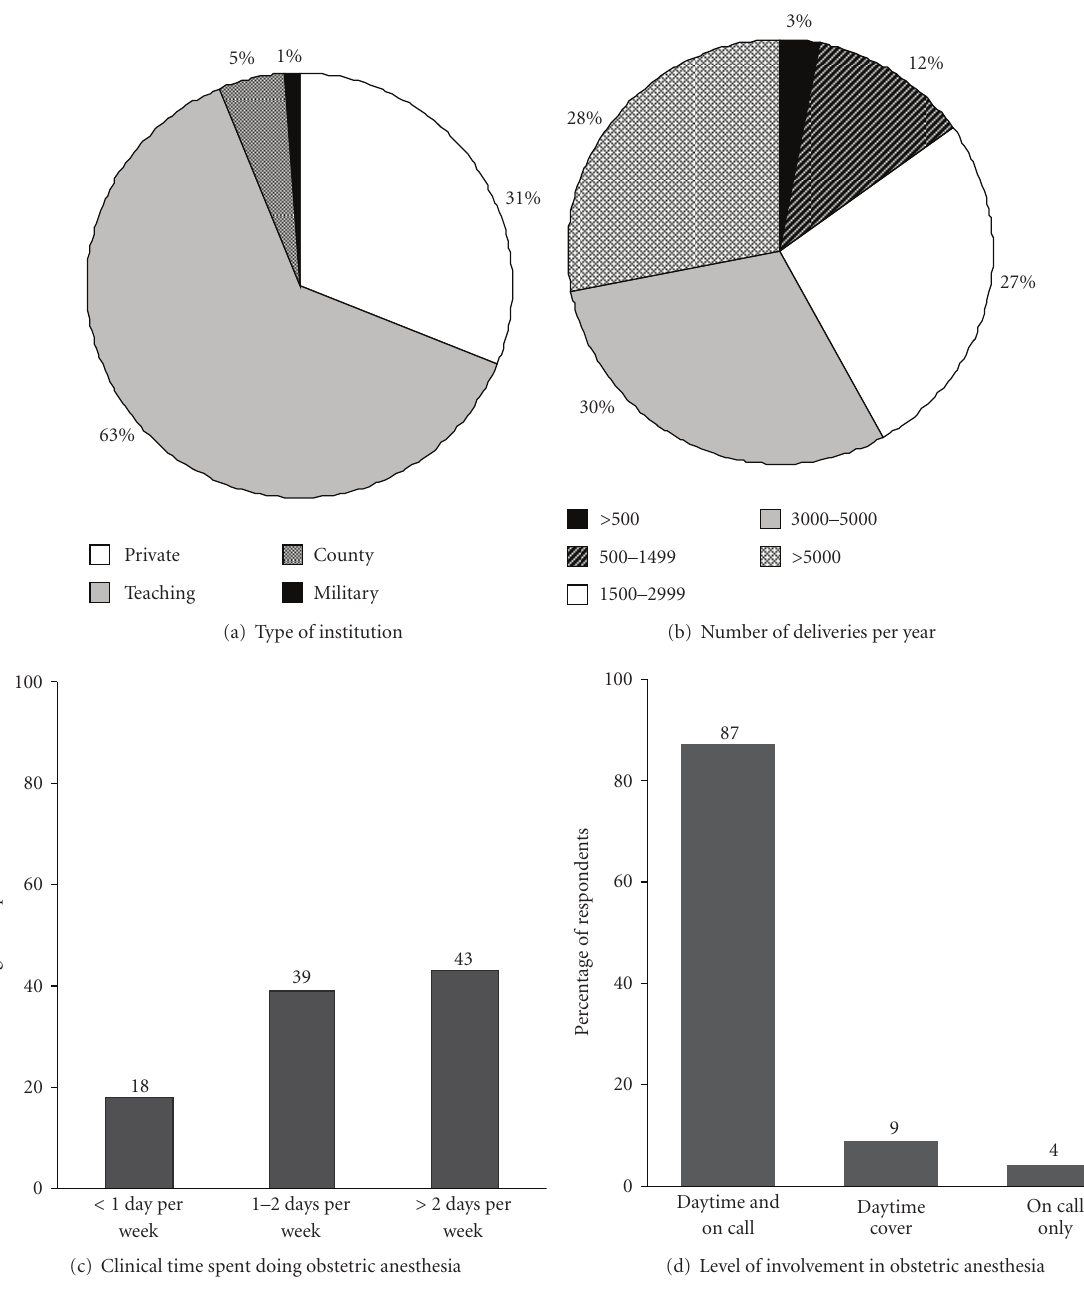
Figure 1: The Demographics of Survey Respondents’ Clinical